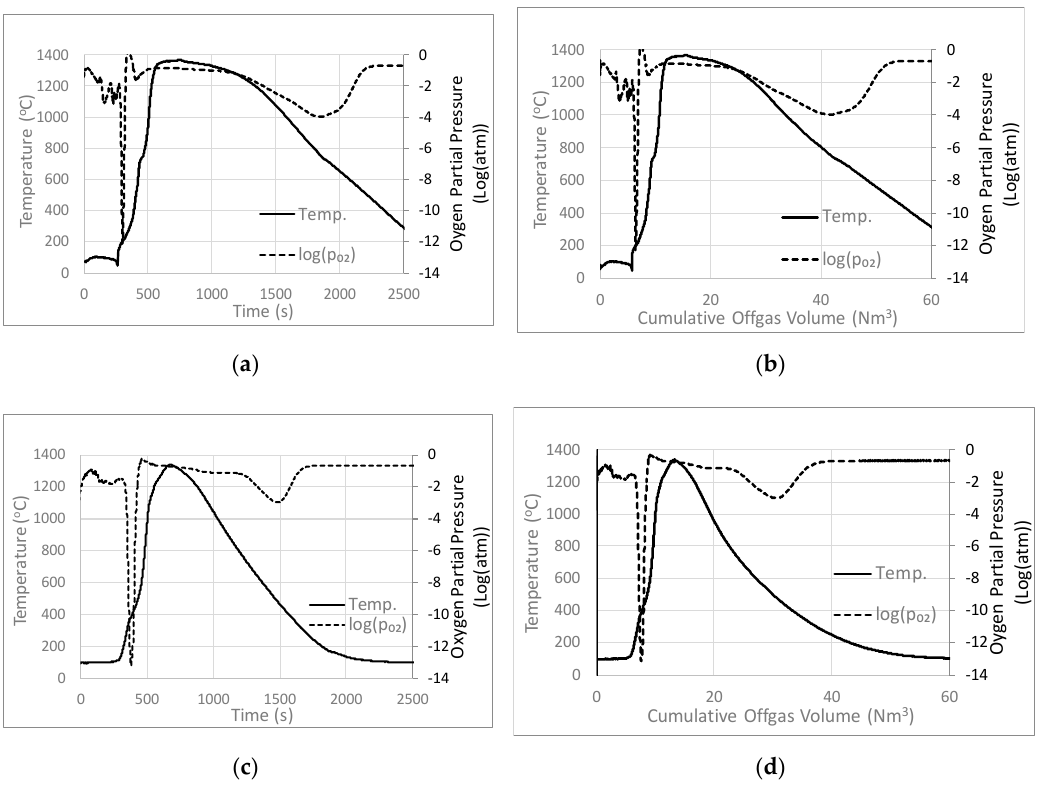
Figure 5. Temperature and p O2 profile measured for ( a , b ) low draft pressure (12.7 kPa draft pressure, 36 kg coke /t feed ) and ( c , d ) high draft pressure (16.7 kPa draft pressure, 36 kg coke /t feed ).